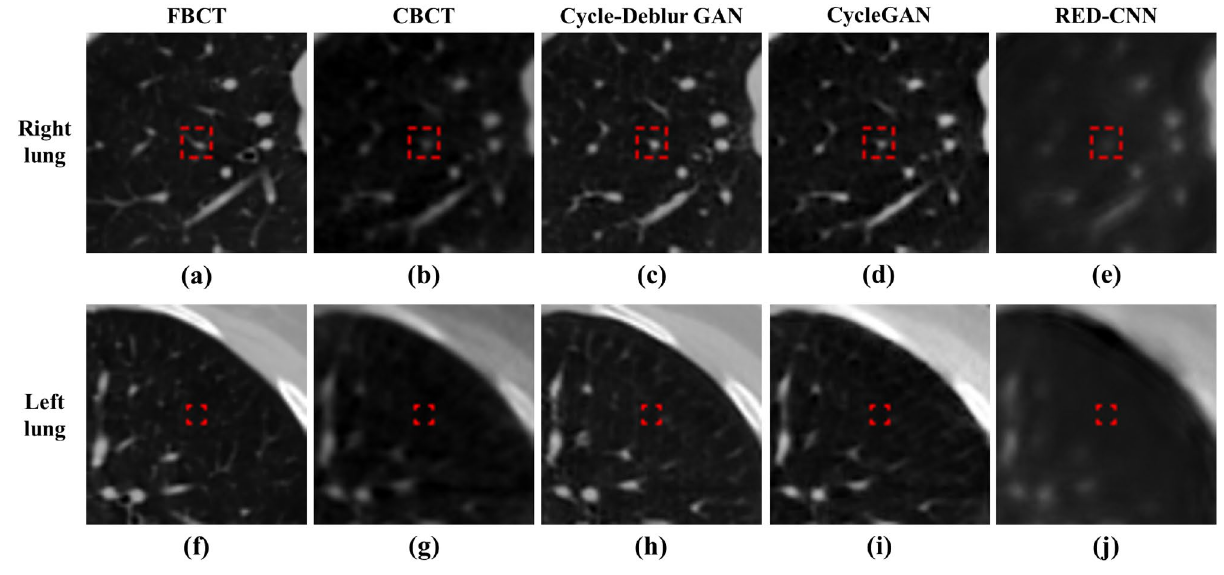
Figure 6. The right and left lung ROIs for quantitative evaluation are shown in ( a , f ): FBCT, ( b , g ): CBCT, ( c , h ): Cycle-Deblur GAN, ( d , i ): CycleGAN and ( e , j ): RED-CNN were performed by XVI software and PMOD software. (W = 1450, L = − 225 for all CT images).